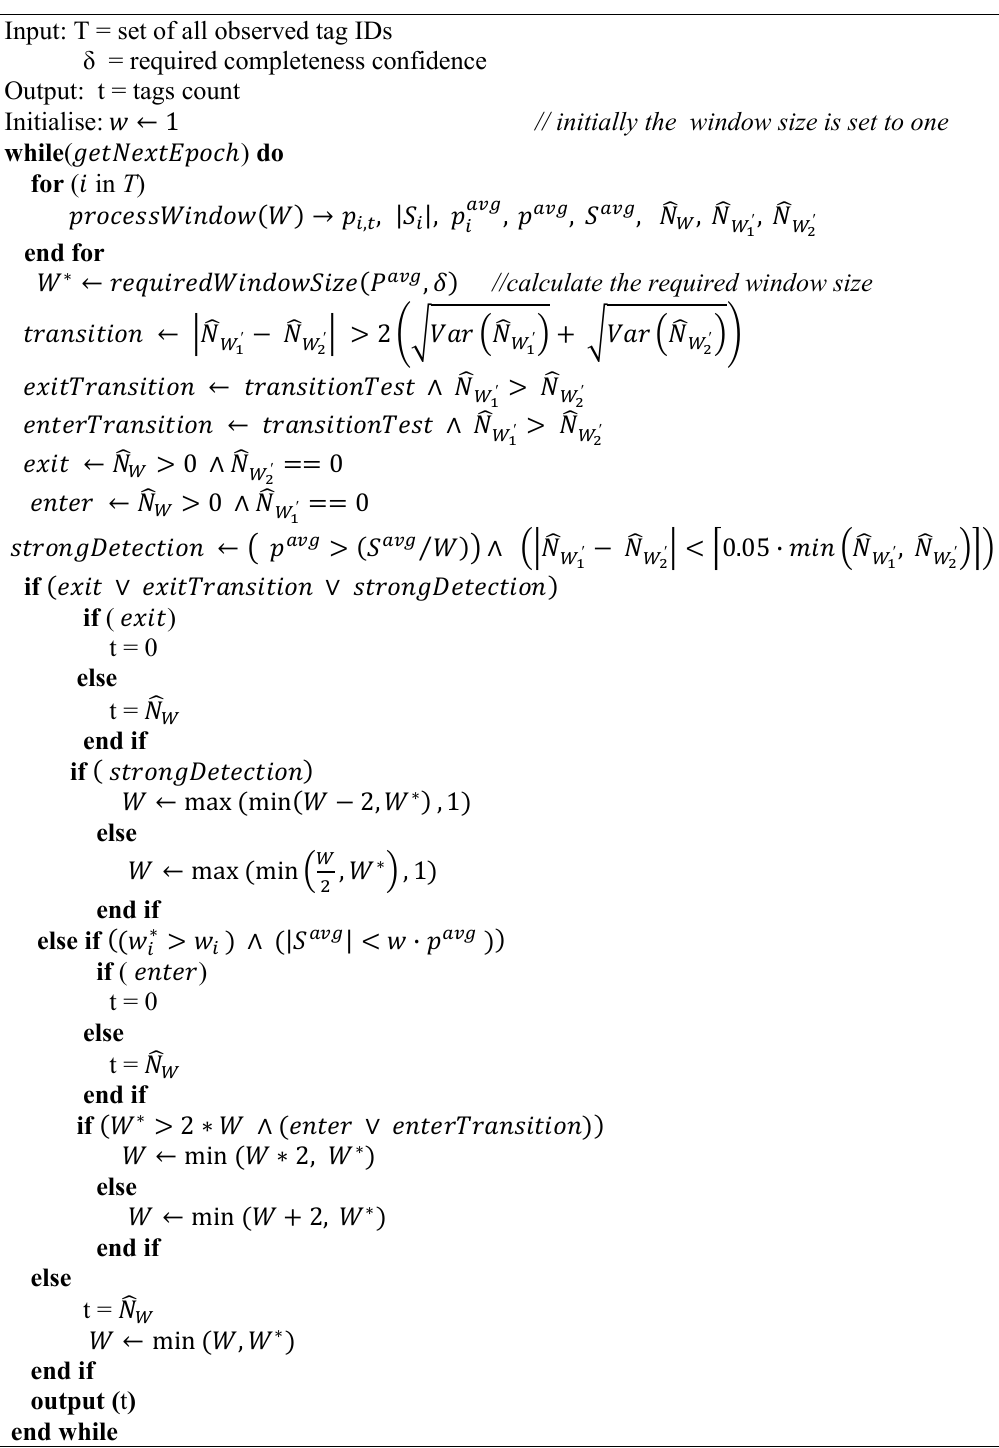
Figure 4. WSTD- π multi-tag cleaning